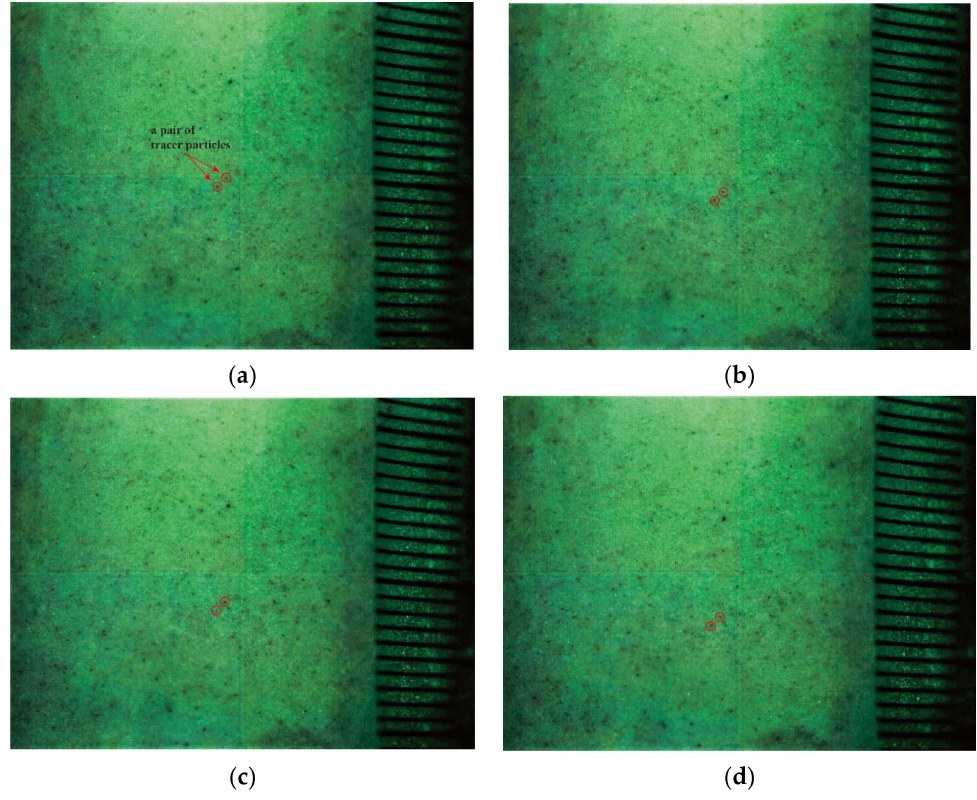
Figure 2. The successive frames of tracer particles are captured by a high-speed camera: ( a ) 1st frame; ( b ) 2nd frame; ( c ) 3rd frame; ( d ) 4th